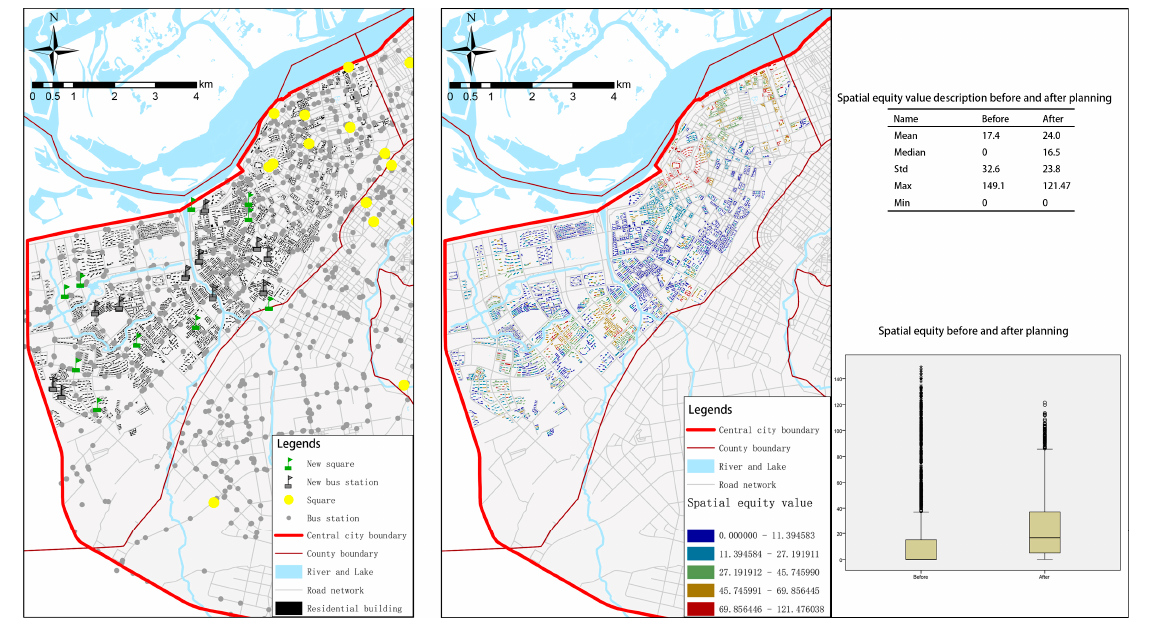
Figure 6. Comparison of the results before and after the spatial planning intervention of sports squares. Asterisks and circles represent